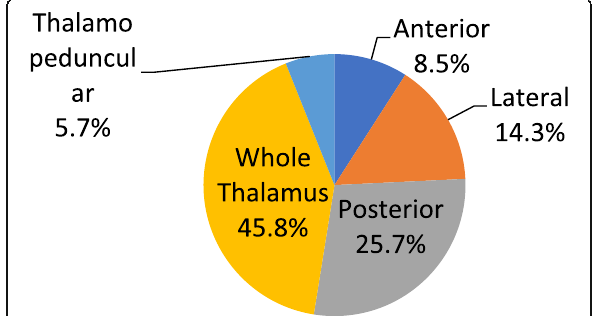
Fig. 2 Pie chart showing percentage distribution of the topographic